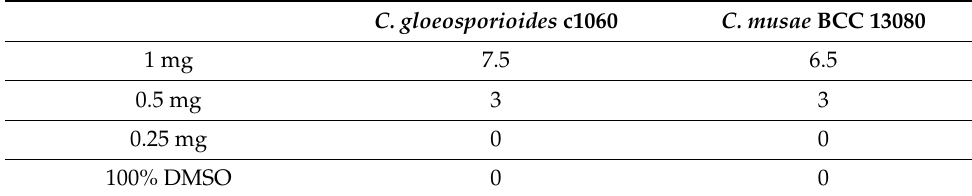
Table 1. Inhibition zone of the biosurfactant sample against Colletotrichum sp. in milliliters.